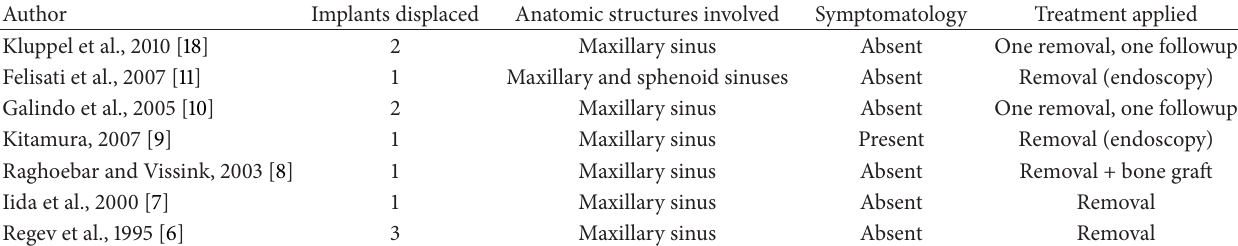
Table 1: Treatment options proposed by different